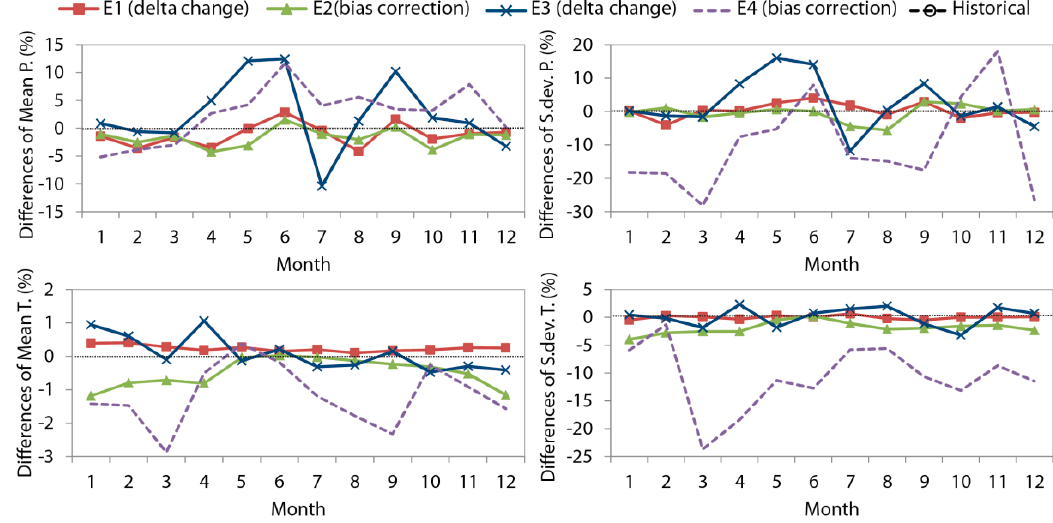
Figure 15. Monthly differences in mean and standard deviation in an average year between distributed (D) and lumped (L) approaches ((L − D)/D) × 100) for the four ensembles scenarios (E1, E2, E3 and E4). The equifeasible ensembles (E1 and E2) yields the relative changes closest to zero.